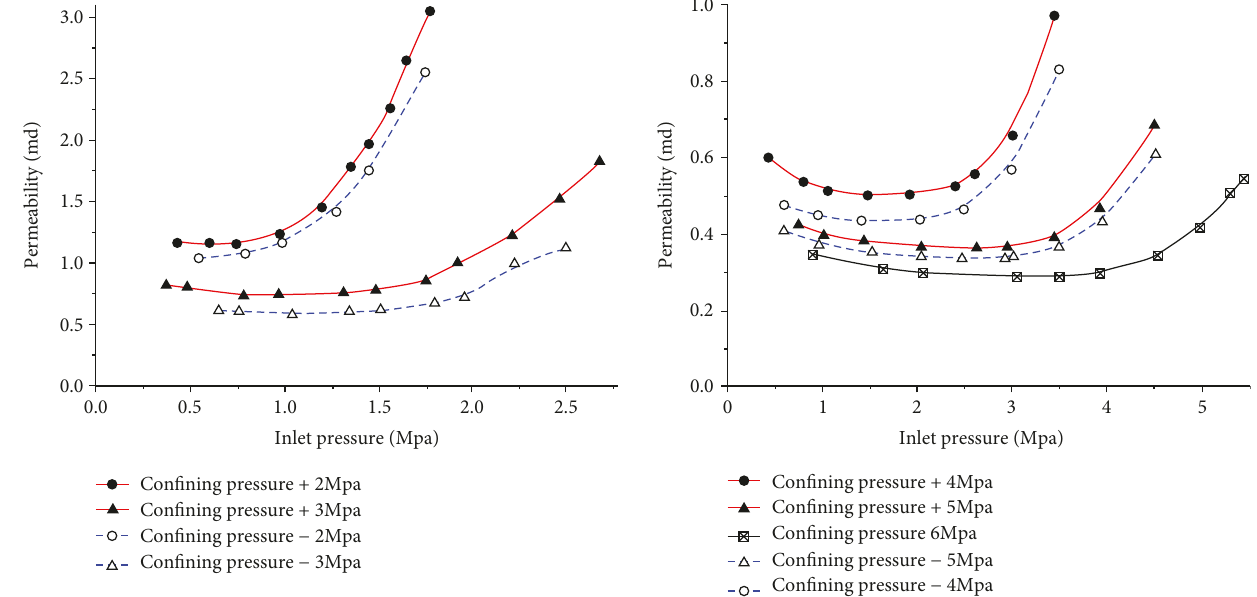
Figure 8: Test results on the pore pressure seepage under constant con fi ning